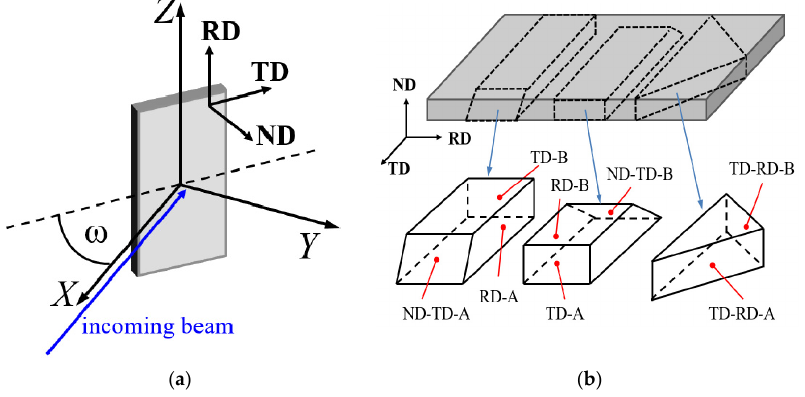
Figure 4. ( a ) Sample orientation in the laboratory coordinate system in order to measure the ND surface of the specimens, ( α , β , γ ) = ( − 15 ◦ , − 90 ◦ ,0 ◦ ) . X-ray di ff raction measurements were carried out on the as-received and all three tensile-deformed specimens in this orientation. The angle between the ND surface and the incoming beam, ω , was 15 ◦ for all measurements. ( b ) For the 23% deformed specimen three pieces were cut out from the plate under di ff erent angles in order to achieve higher χ values for the di ff raction peaks. The measurements were done on eight surfaces denoted as RD, TD, ND-TD, and TD-RD. The double notations mean a flat surface tilted 45 ◦ between the two mentioned surfaces. The A and B notations denote pairs of surfaces, which are symmetrical from the point of view of the Table 1. The Eulerian angles of the specimen rotations in the case of the different measurements. Measured Surface